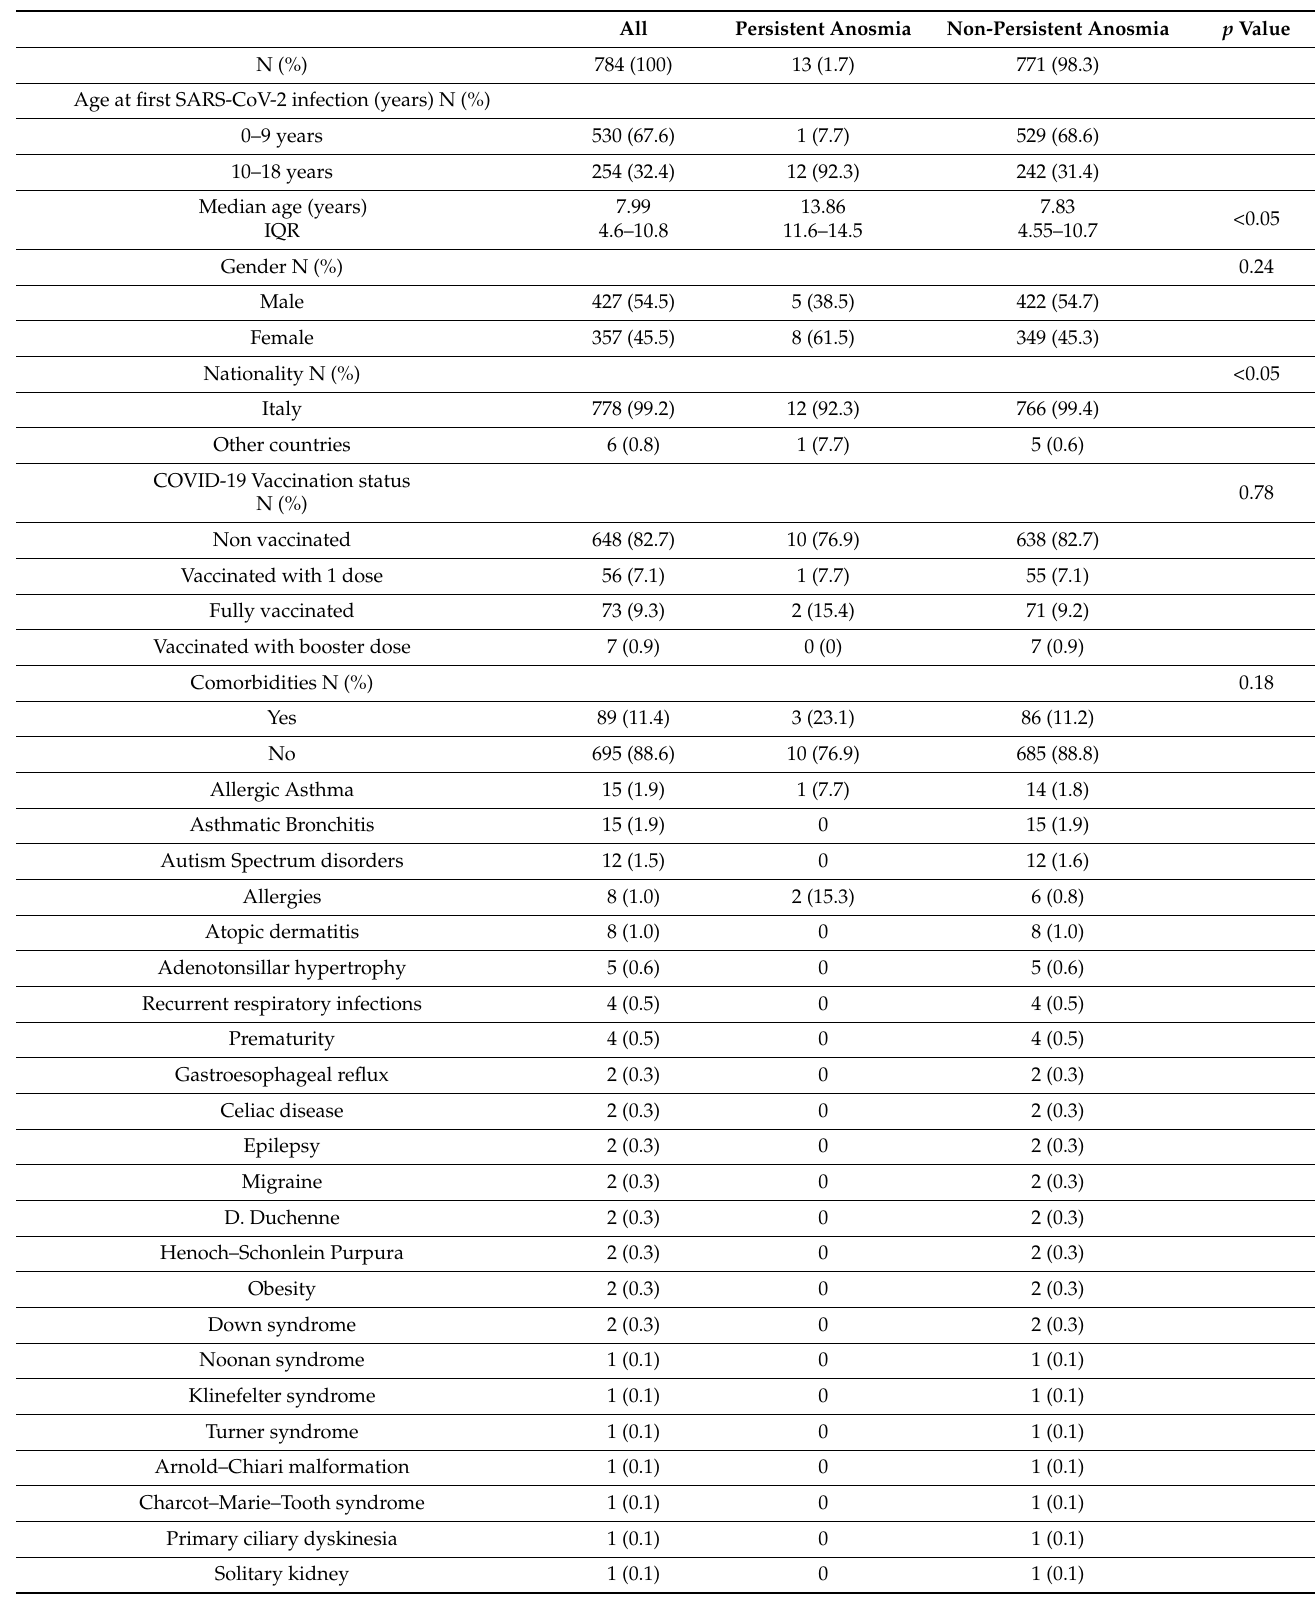
Table 3. Demographic and clinical characteristics of the subject